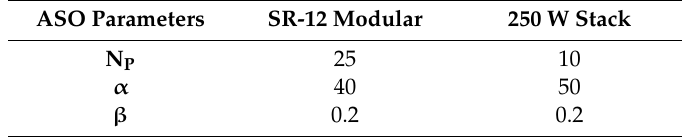
Table 1. Atom search optimization (ASO) adapted controlling parameters.